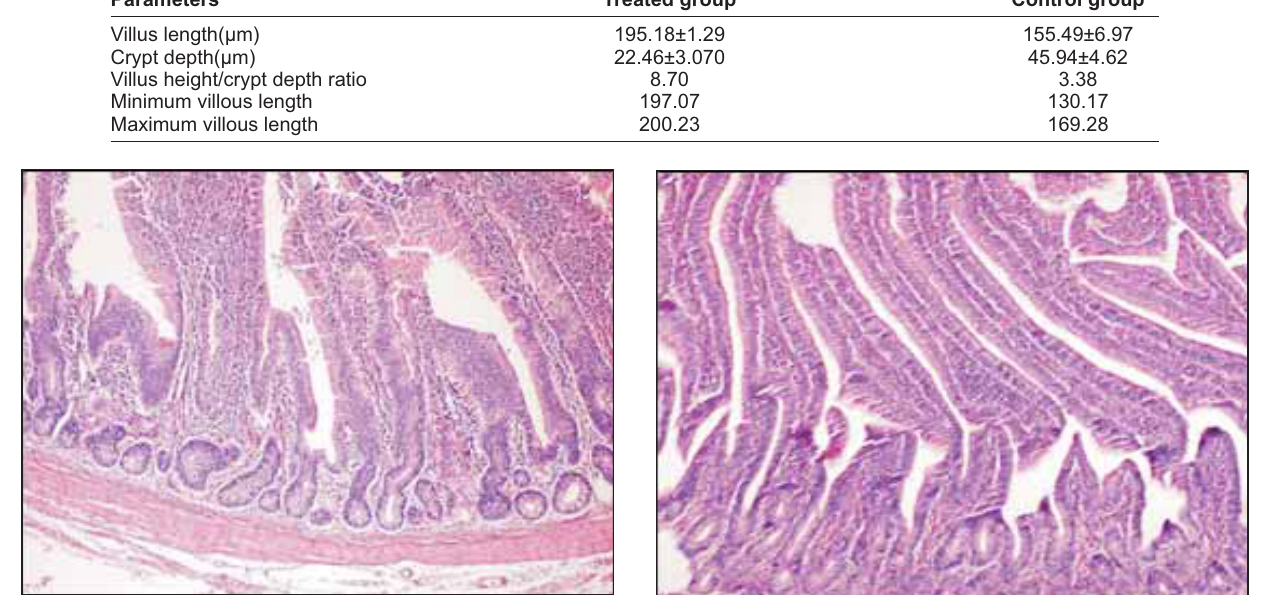
Table-6: Effects of the SC on the ileum morphological parameters of broiler chickens.